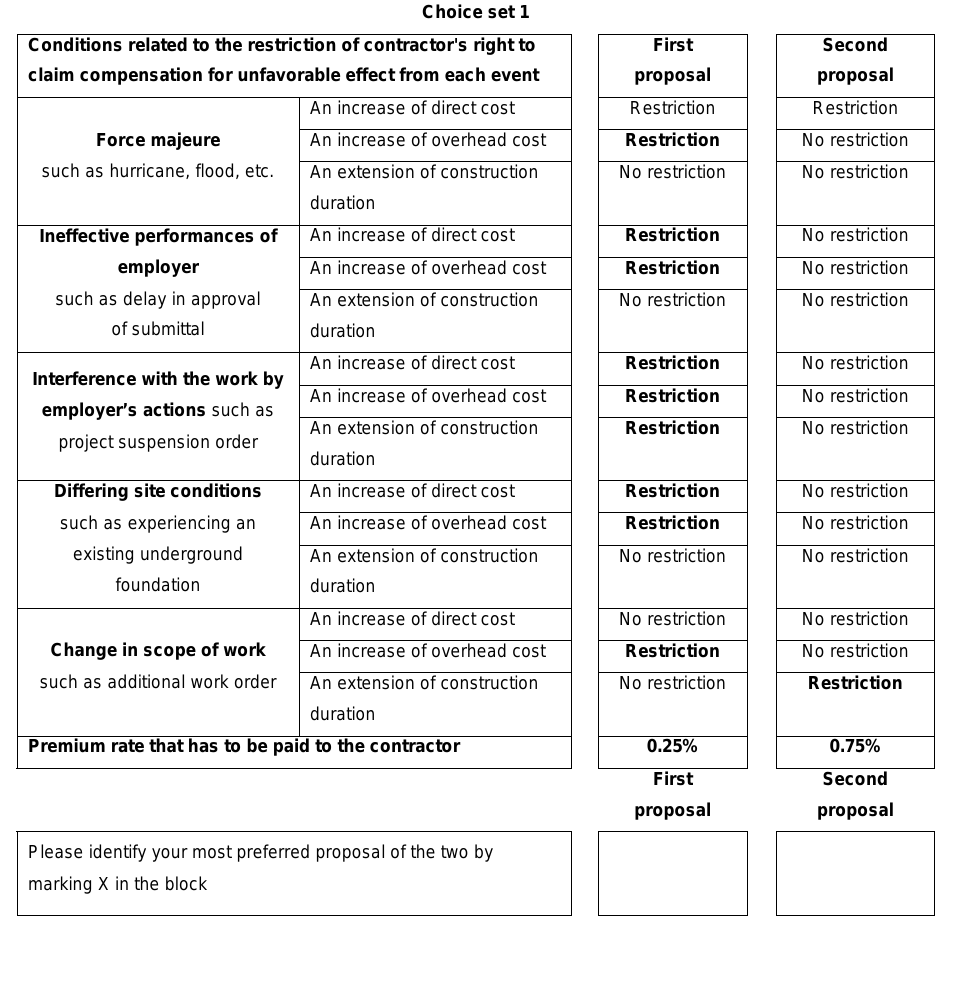
Figure 2: Example of choice set presented to